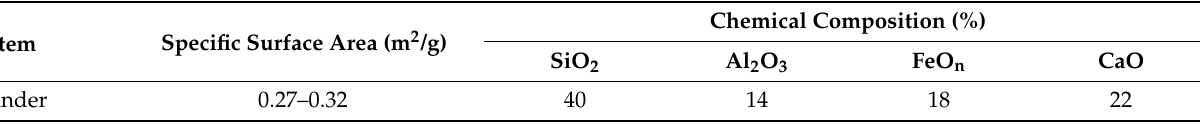
Table A4. Fundamental properties of